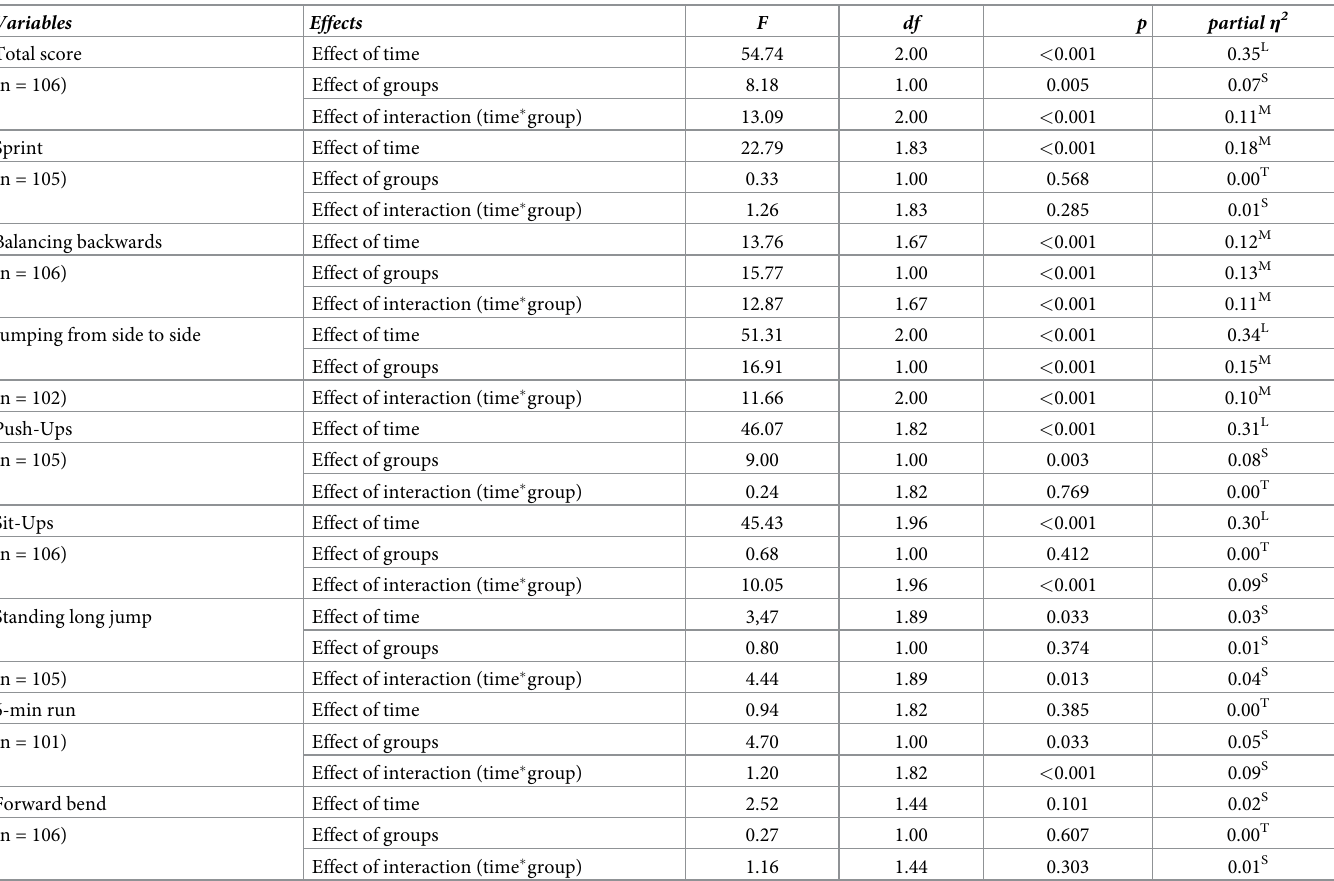
Table 2. Z-scores of motor performance considering all three time